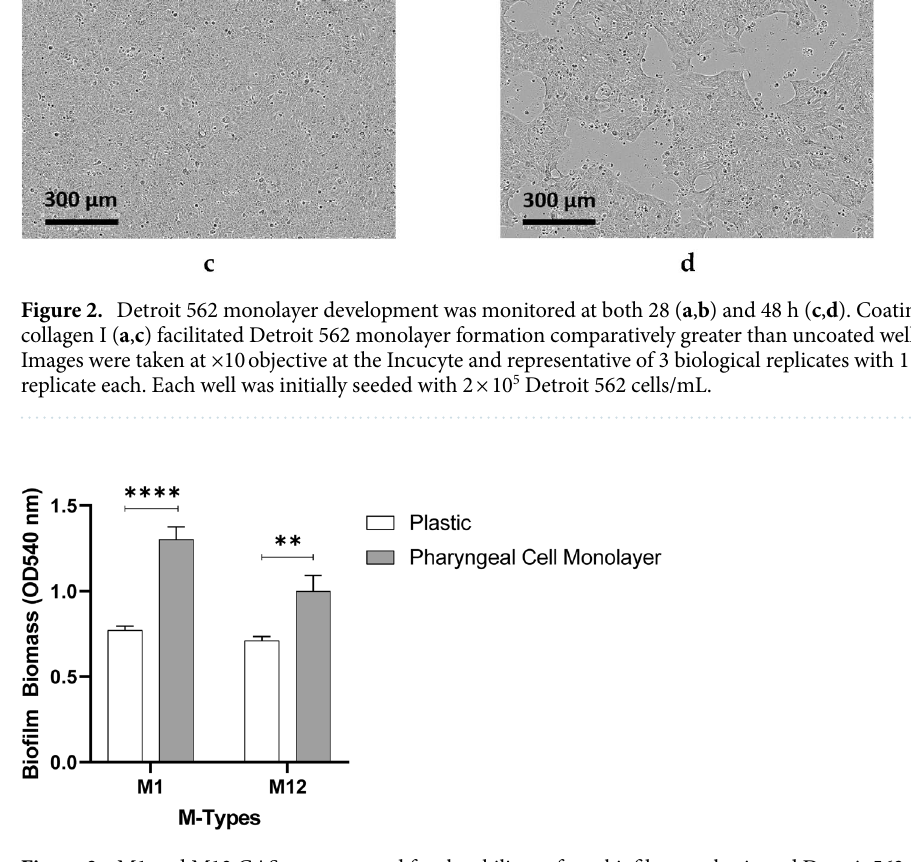
Figure 3. M1 and M12 GAS were assessed for the ability to form biofilm on plastic and Detroit 562 pharyngeal cell monolayers. 48 h biofilms were formed and biofilm biomass ascertained via crystal violet staining. Monolayers with THY (no GAS biofilm) served as media sterility controls and background staining controls, with absorbance values (supplementary data Table 1) subtracted from those of biofilm samples. Data represents mean ± SEM, ** (P ≤ 0.01) and **** (P ≤ 0.0001); n = 3 biological replicates, with 3 technical replicates